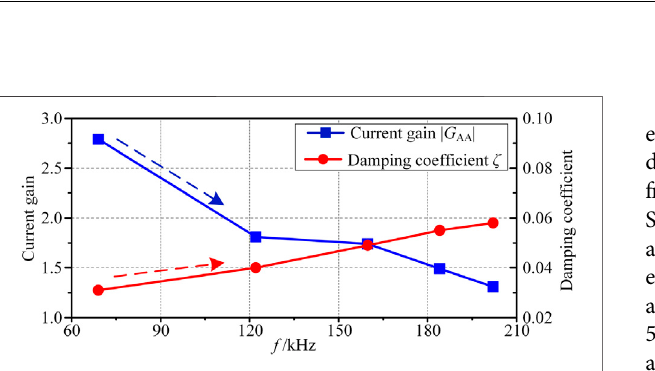
FIGURE 9 | Capacitor current response to the injected bridge current at different frequencies.